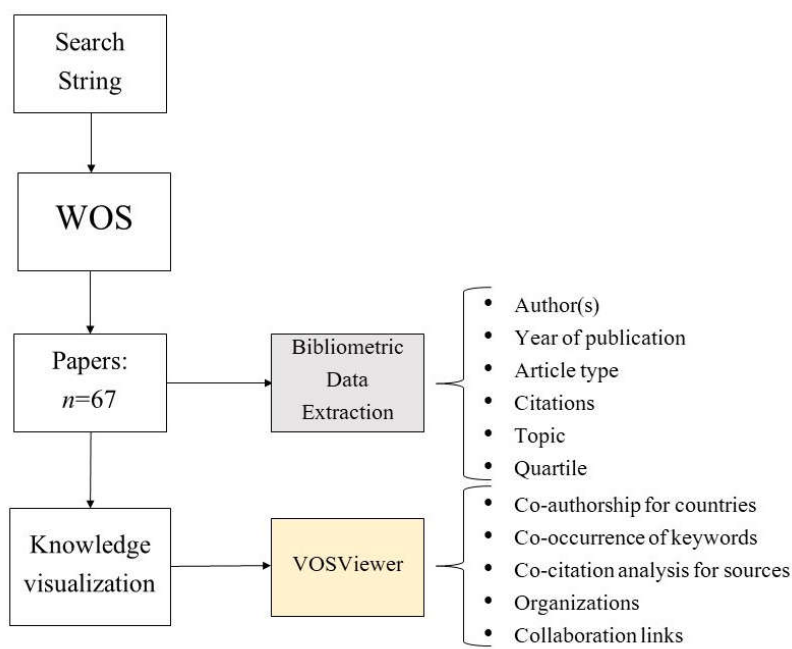
Figure 1. Flowchart of the study. Abbreviations: WOS, Web of Science.